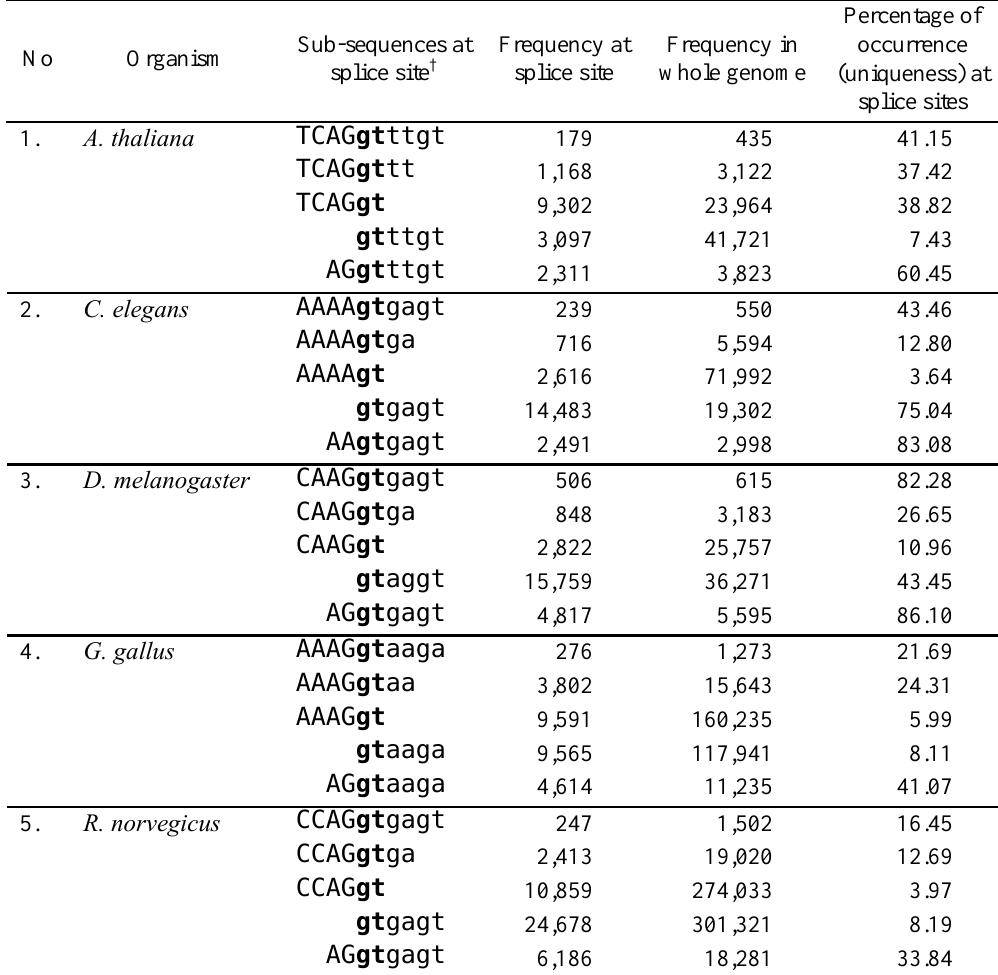
Table 5a. Percentage of occurrence (uniqueness) of different sub-sequences (with highest frequency) of size ten at the donor splice site region and the whole genome of the